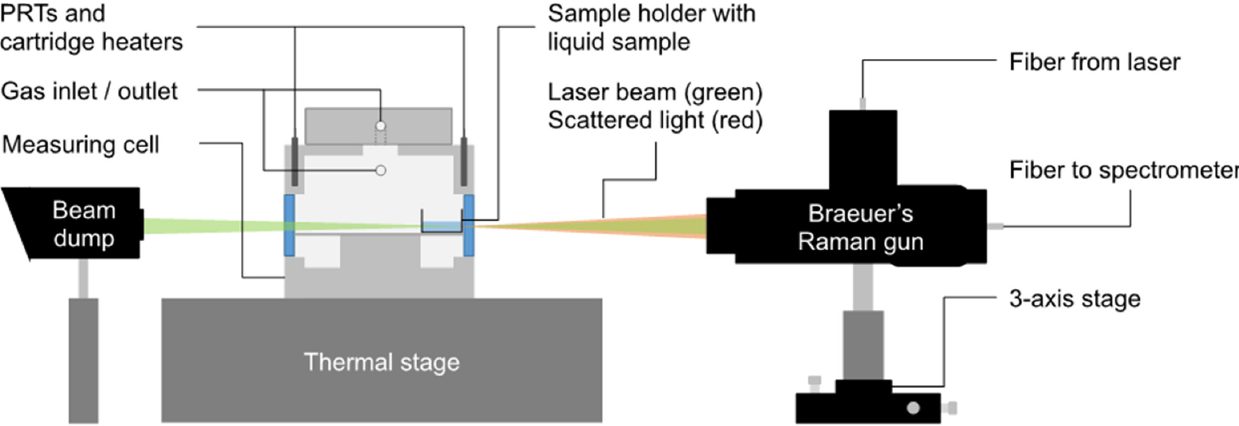
Figure 1. Schematic diagram of the experimental setup, consisting of Braeuer’s Raman gun mounted on a 3-axis stage ( right ), the measuring cell, including the sample holder ( middle ), and a beam dump ( left ) to absorb the excessive laser light. The gas outlet is connected to a diaphragm vacuum pump via a valve (both not shown in the diagram); the gas inlet is connected the filling and pressure measurement circuit.